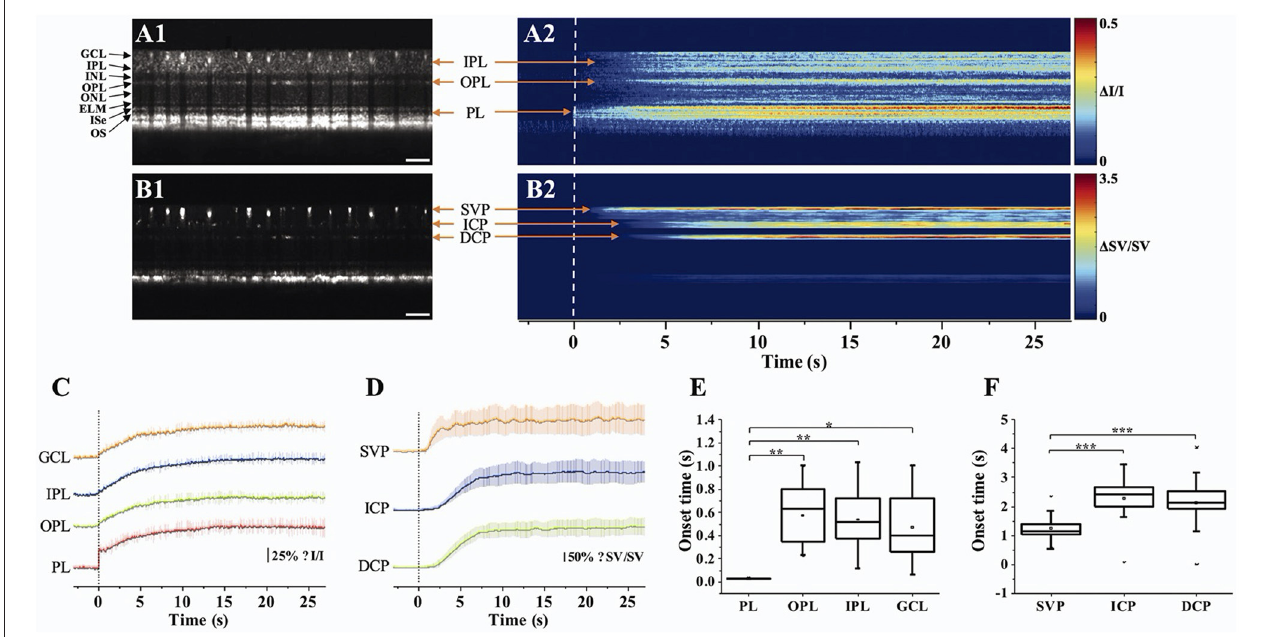
FIGURE 6 | Retinal neurovascular coupling and inner retinal IOS response. (A) Representative flattened (A1) OCT B-scan and (A2) spatiotemporal neural-IOS map. (B) Representative flattened (B1) OCTA B-scan and (B2) spatiotemporal hemodynamic-IOS map. Scale bars in (A1,B1) indicate 500 µ m. (C) Neural-IOS changes of photoreceptor layer (PL), outer plexiform layer (OPL), inner plexiform layer (IPL), and ganglion cell layer (GCL). (D) Hemodynamic-IOS changes of superficial vascular plexiform (SVP), intermediate capillary plexiform (ICP), and deep capillary plexiform (DCP). (E) Averaged onset times of neural-IOS changes at PL, OPL, IPL, and GCL. (F) Averaged onset times of hemodynamic-IOS changes of SVP, ICP, and DCP. Modified with permission from Son et al. ( 63). P values for statistical significances are indicated by asterisks: * P < 0.05; ** P < 0.01; *** P <